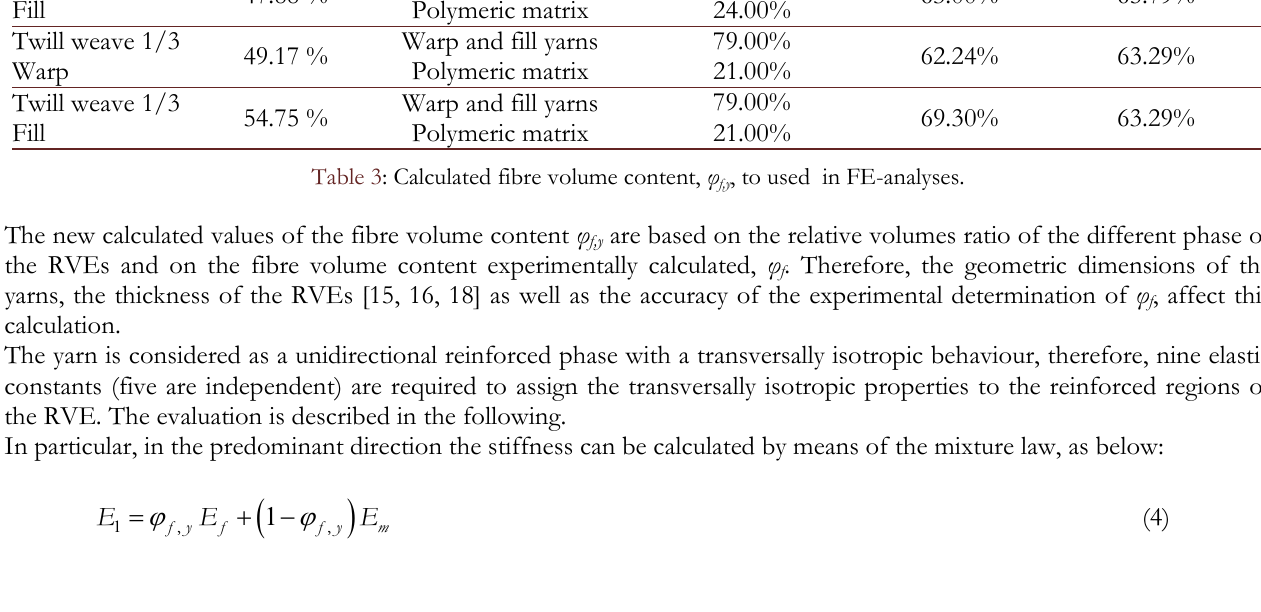
Table 3: Calculated fibre volume content, φ